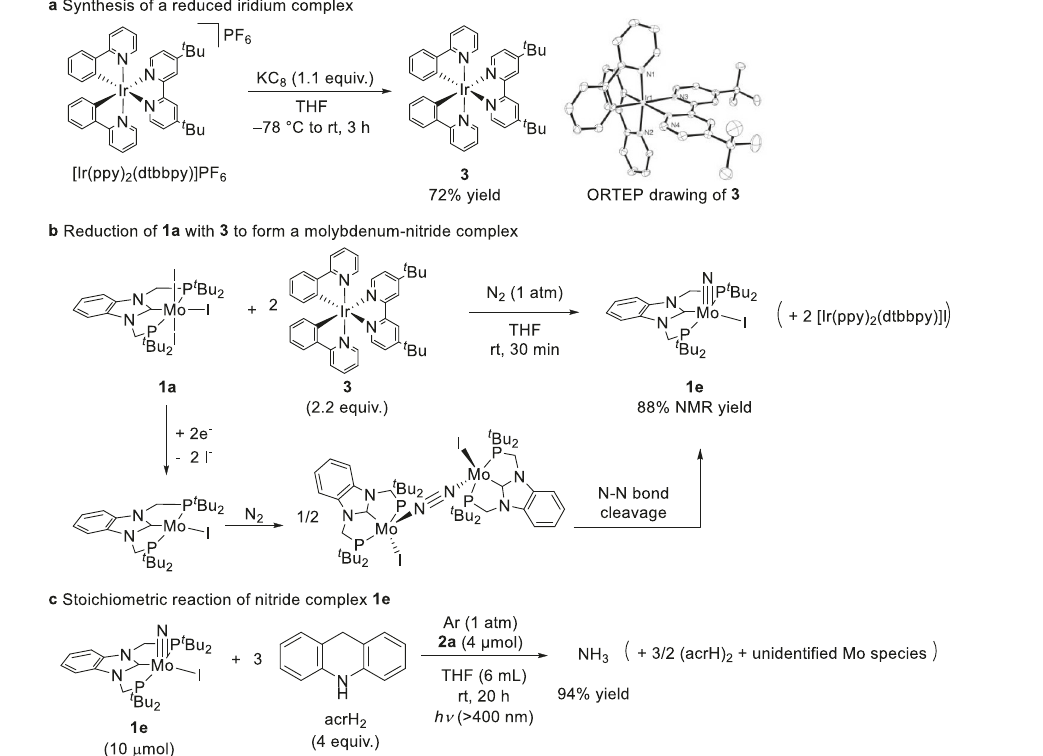
Fig. 4 | Stoichiometric reactions of iridium and molybdenum complexes. a Reduction of iridium complex [Ir(ppy) 2 (dtbbpy)]PF 6 into [Ir(ppy) 2 (dtbbpy)] ( 3 ). b Formation of molybdenum – nitride complex ( 1e ) from the reaction of 1a with 3